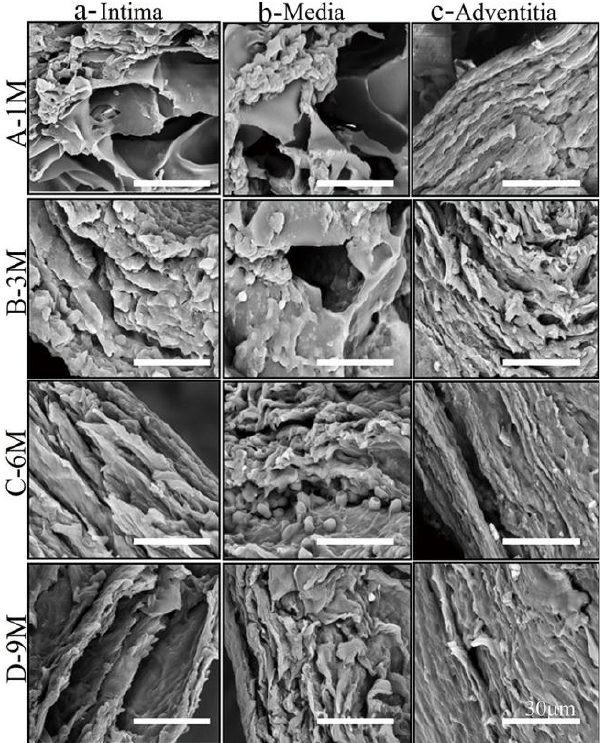
Figure 6. SEM images of matrix fibers in different structural layers of SFTSs after implantation. ( A – D ) Represent the different time points after implantation; ( a – c ) represent the different layers of the wall. The scale bar is 30 µ